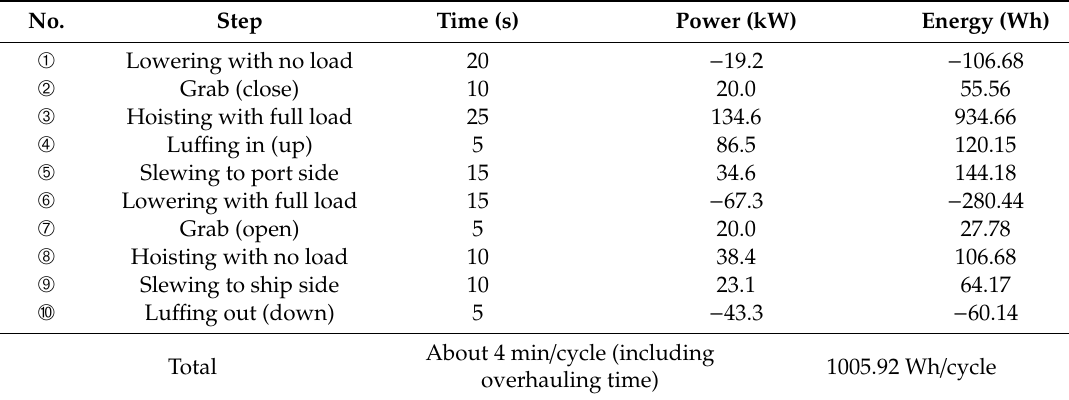
Table 8. Expected power demands for deck crane